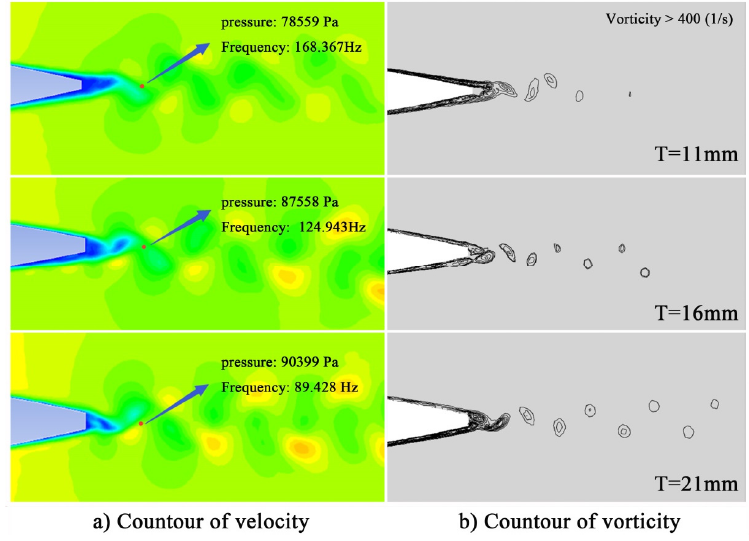
Figure 10. Comparison of trailing edge with different thickness.